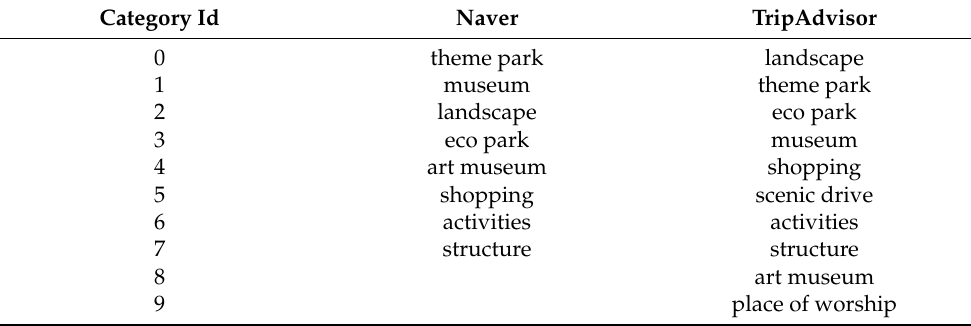
Table 4. Categories of